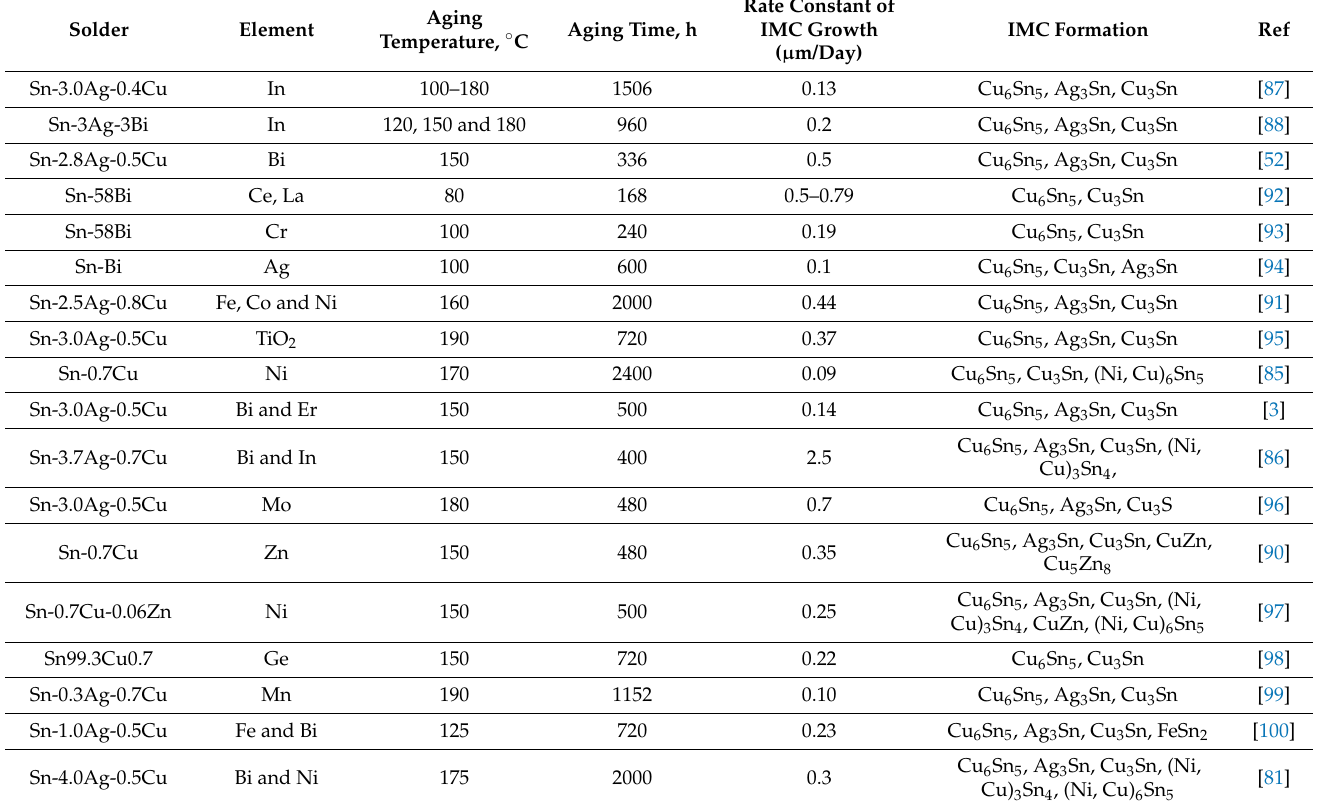
Table 3. Effect of alloying element and aging time on solder alloys interfacial